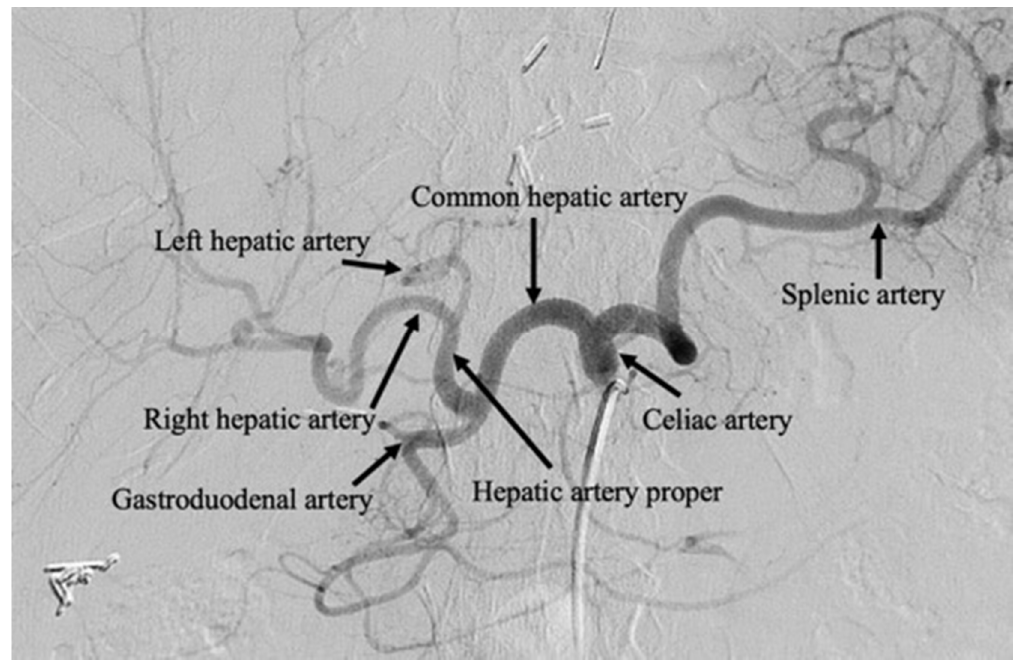
Figure 1. Celiac artery angiogram. Celiac artery angiography performed after selective arterial catheterization of the celiac axis. Transarterial therapies are typically performed beyond the left and right hepatic arteries, with microcatheters positioned in the segmental and subsegmental branches.